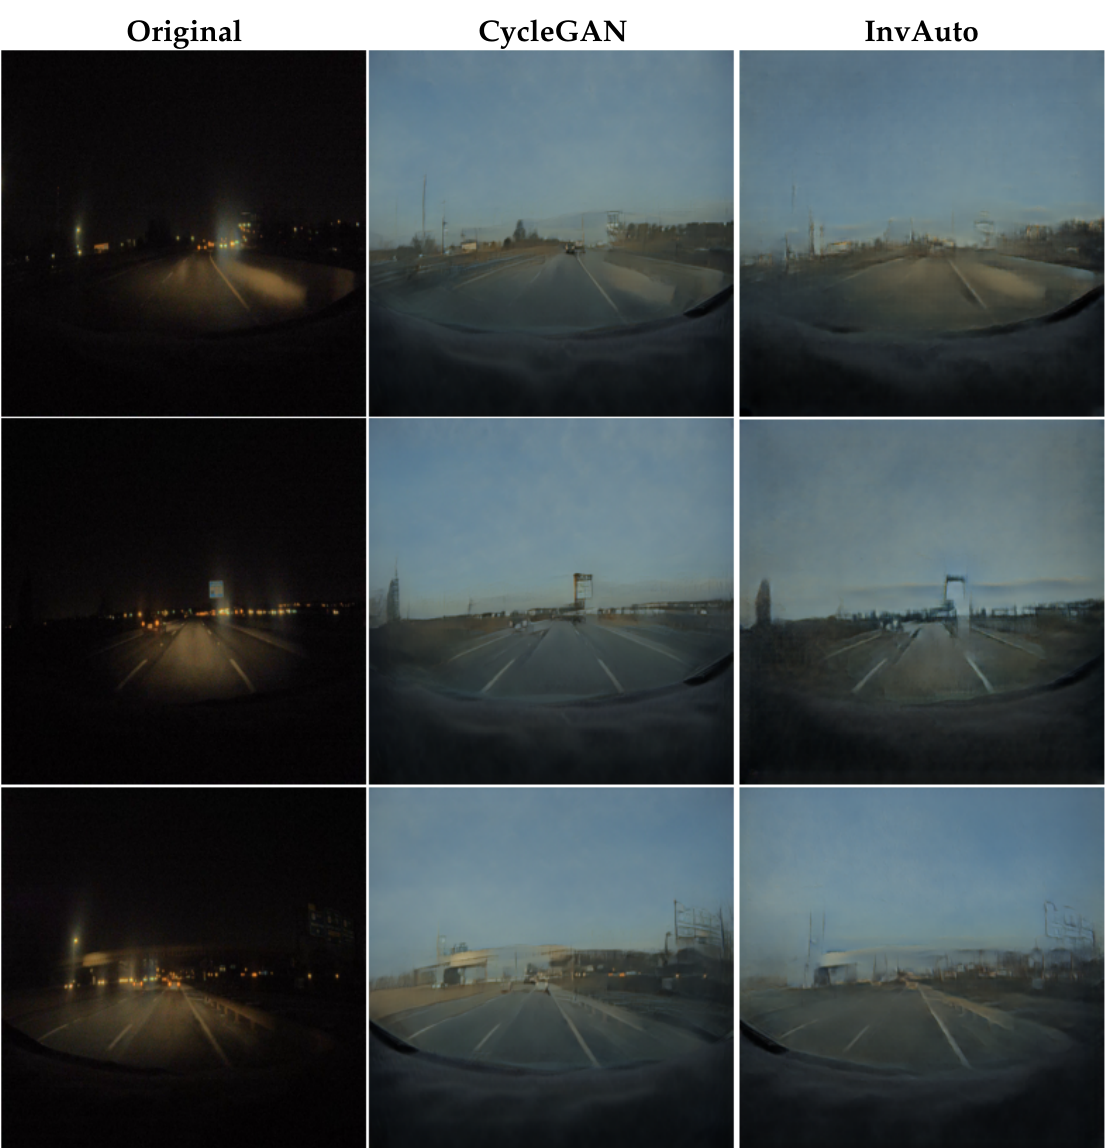
Figure A12. Experimental results with autonomous driving system: night-to-day